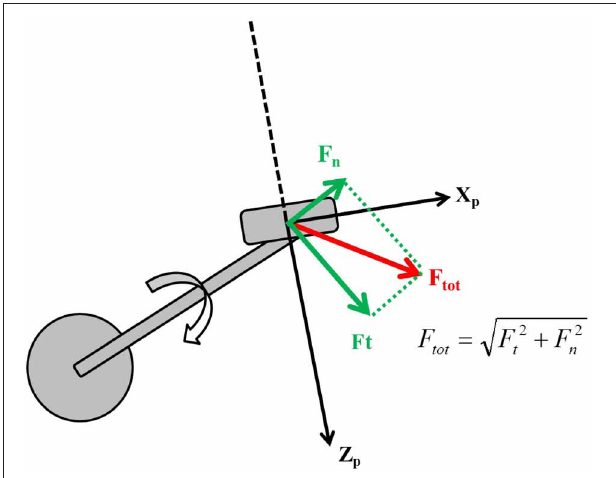
FIGURE 1 | Forces applied to the pedal in the pedal reference system { X p , Z p } .